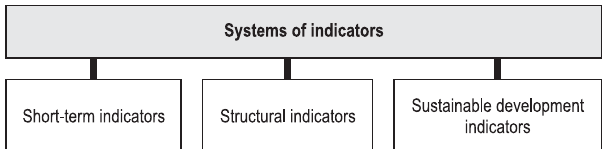
Fig. 1. Systems of sustainable development indicators used by the European